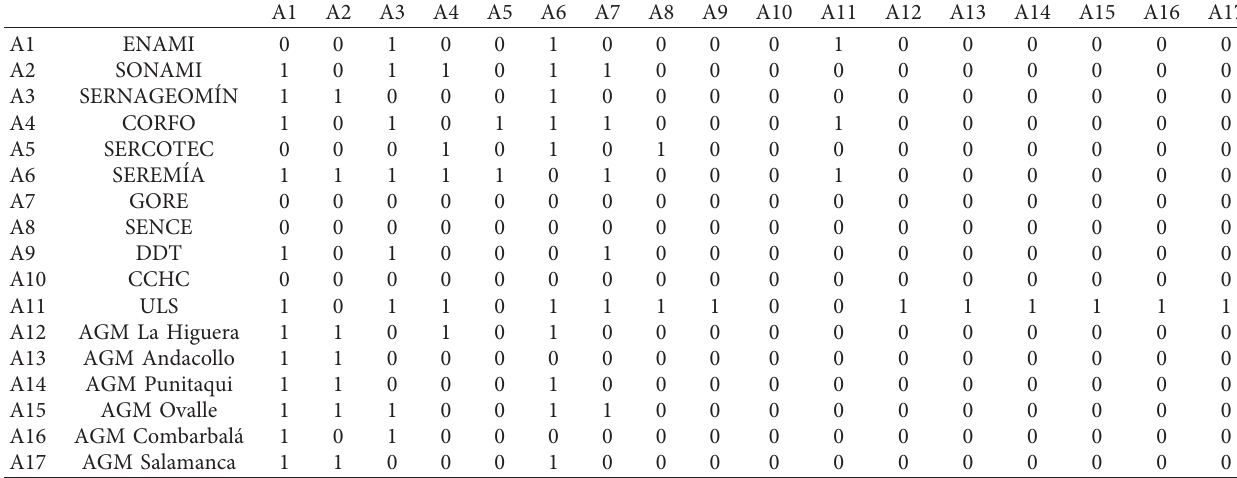
Table 4: Adjacency